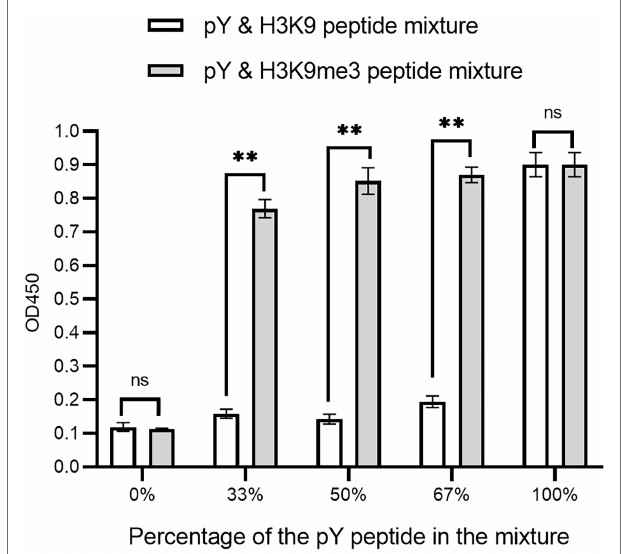
Cbx1-and-FynSH2-containing phage binding to the mixtures of pY and H3K9me3 peptides with different ratios. The proportion of pY peptide in the mixtures ranged from 0 to 100%. The mixtures of pY and H3K9 peptides were taken as the negative control. The experiments were repeated three